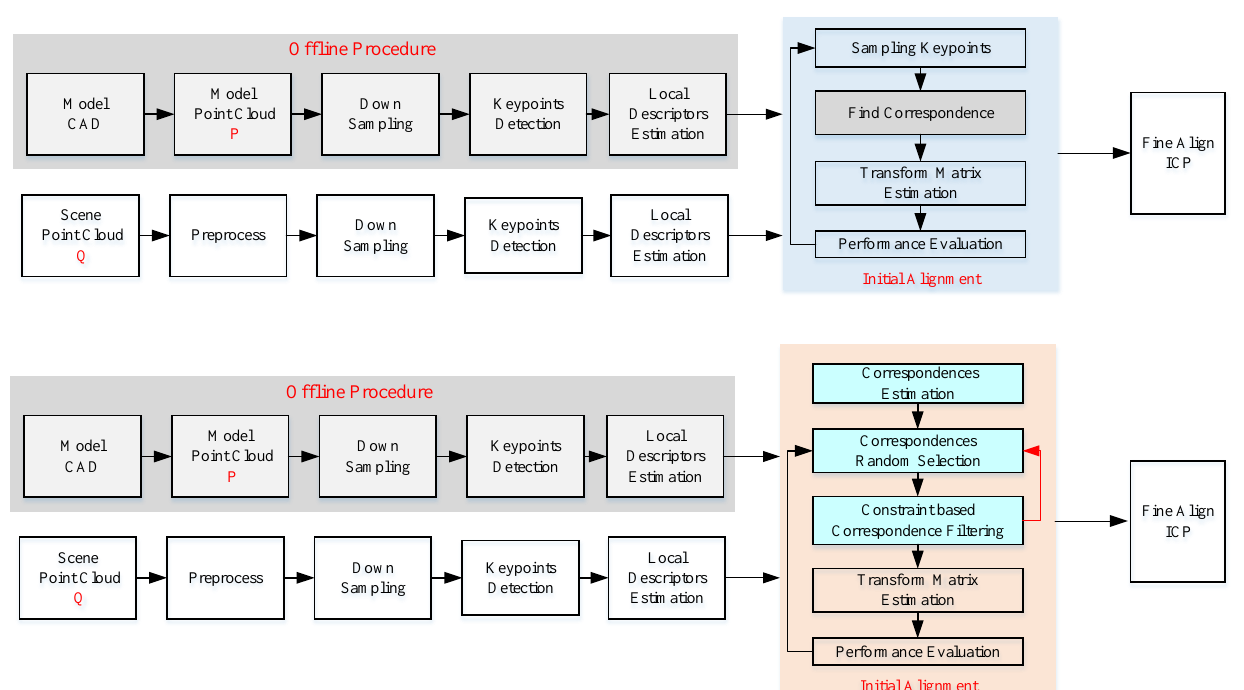
Figure 1. Diagram of the original SAC-IA algorithm and the proposed efficient SAC-IA